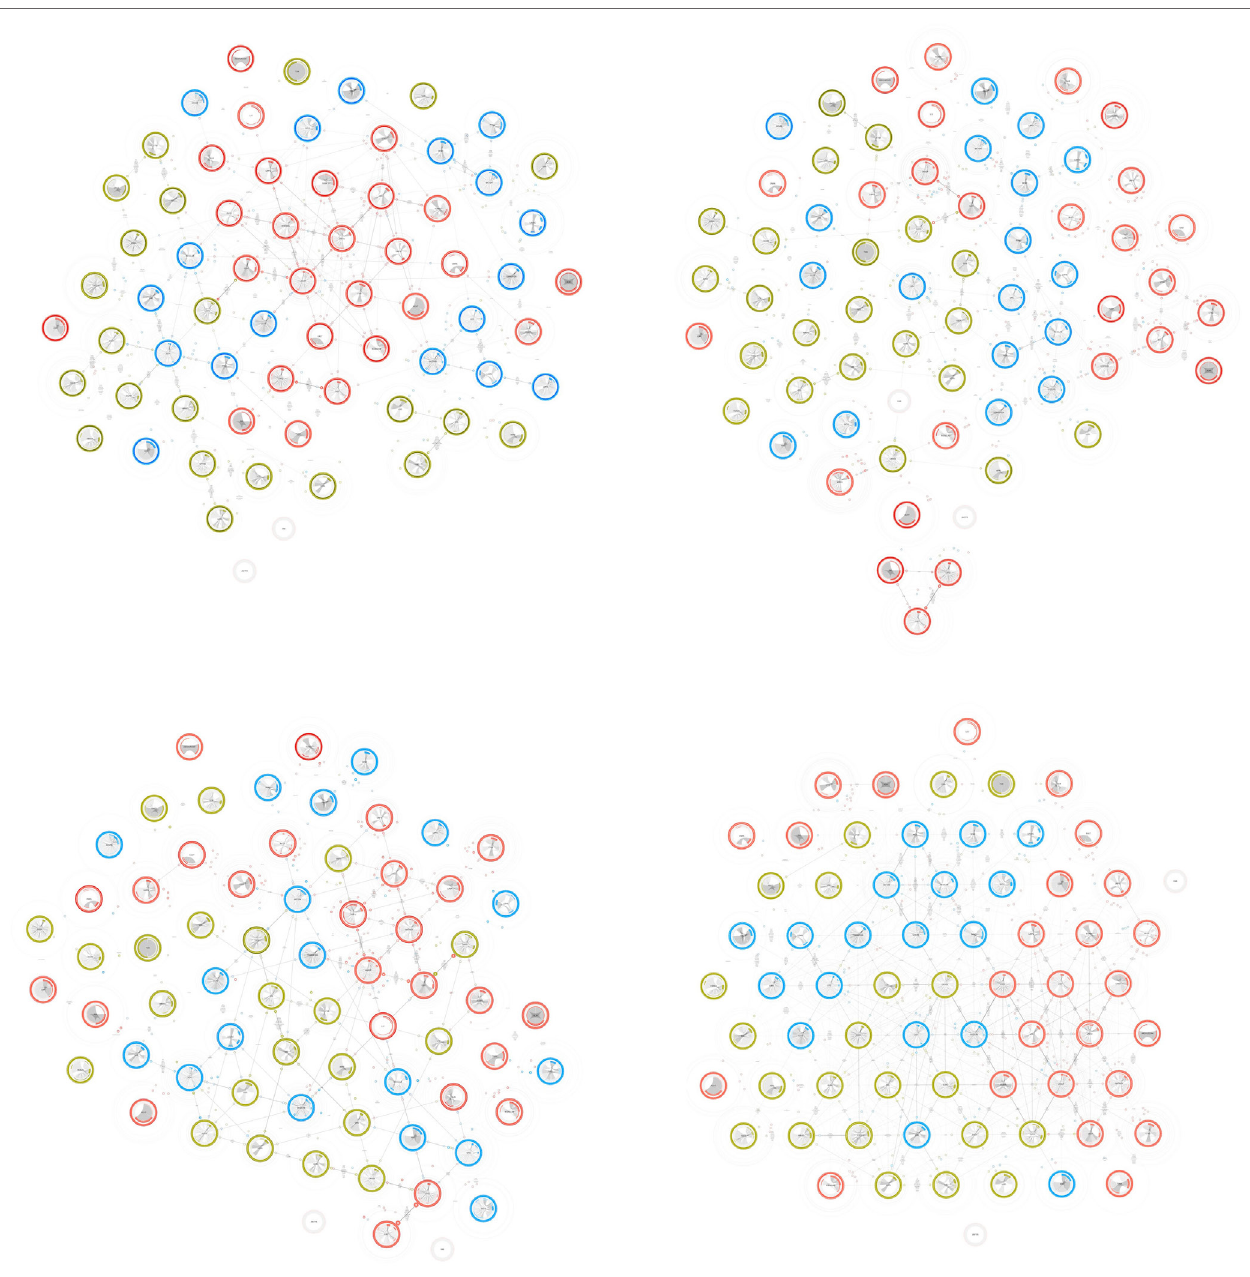
FigUre 2 | The various constellations of the Affinity Map. The affinities that regulate the distances (see Figure 1 ) can be activated and deactivated producing different arrangements. Constellations are displayed from the upper-left in text organization, namely advising, publications, teaching, and keywords.